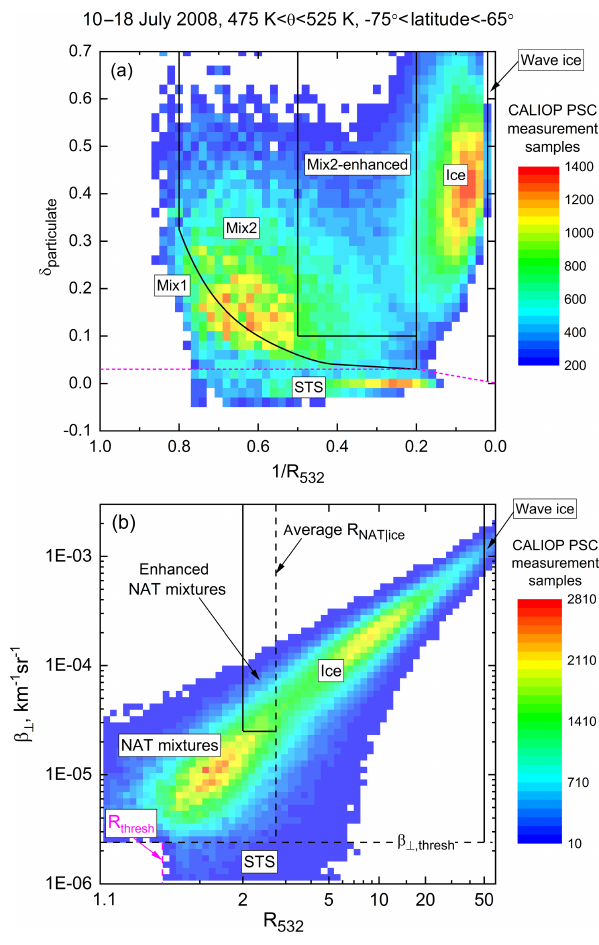
Figure 5. The 2-D histogram of CALIOP PSC data for the period 10–18 July 2008, latitudes 65–75 ◦ S, and potential temperatures ( θ ) 475–525K plotted in the CALIOP v1 (a) and v2 (b) composition classification coordinate